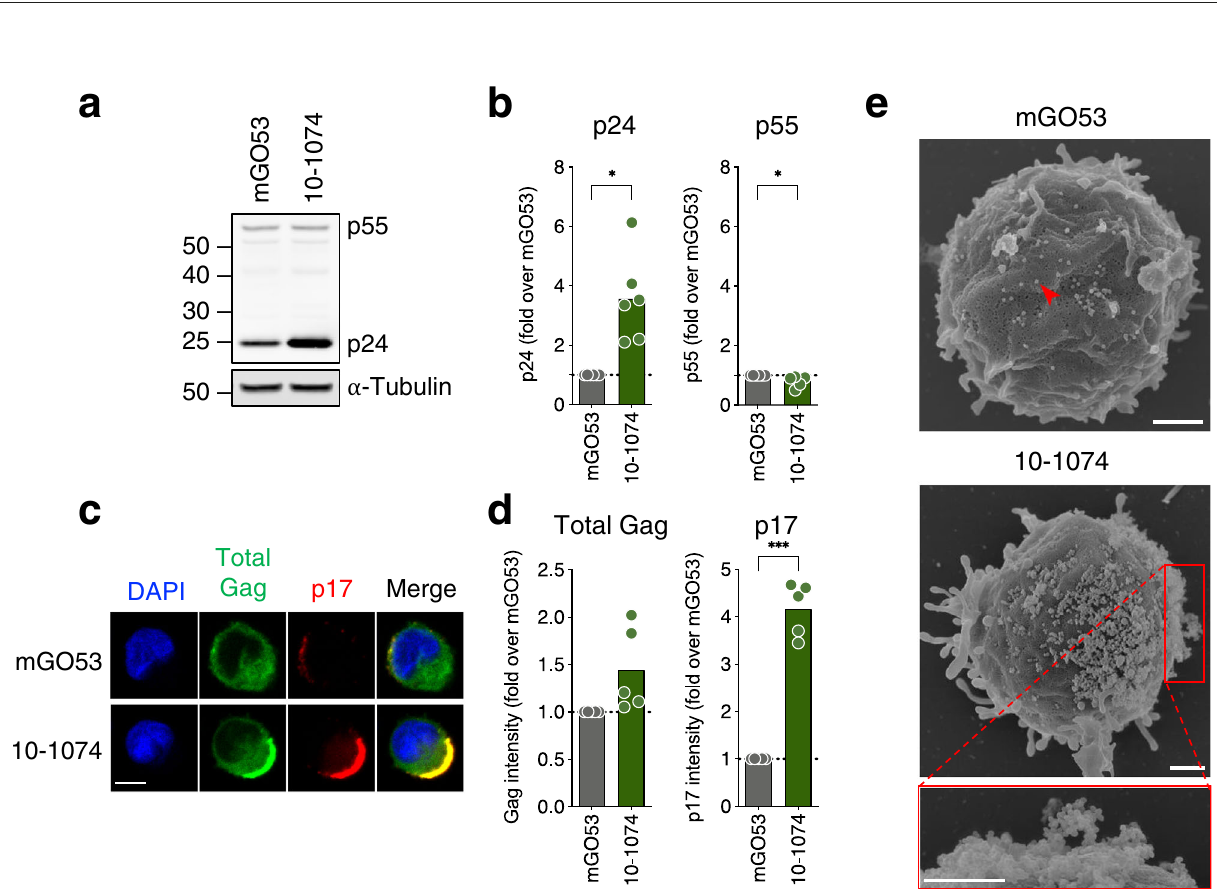
Fig. 2 bNAbs retain mature HIV-1 particles at the plasma membrane. a Western blot analysis of Gag in CD4 T cells infected with HIV-1 (CH058) for 48 h and then cultivated 24h with an isotype control (mGO53) or a bNAb (10 – 1074). α -Tubulin was used as a loading control. Molecular weights (kDa) are indicated on the left. One representative experiment (out of six) is shown. b Western blot analysis of p24 (left) and p55 (right) levels in HIV-1-infected (CH058) CD4 T cells cultivated for 24 h with an isotype control (mGO53) or a bNAb (10 – 1074). Results are normalized to α -Tubulin and to mGO53. Each dot represents a donor of CD4 T cells ( n = 6). * p = 0.0313 (two-tailed Wilcoxon test). Bars represent the mean. c Representative confocal microscopy images of infected CD4 T cells (CH058) cultivated for 24 h with an isotype control (mGO53) or with a bNAb (10 – 1074). Cells were stained for intracellular total Gag (green) and p17 (red). Nuclei were stained with DAPI (blue). Scale bar: 5 μ m. One representative experiment (out of fi ve) is shown. d Confocal microscopy analysis of total Gag and p17 intensity levels in infected (CH058) CD4 T cells cultivated for 24 h with an isotype control (mGO53) or with a bNAb (10 – 1074). Results are expressed as the fold-change in Gag staining intensity over mGO53. Each dot represents a donor of CD4 T cells ( n = 5). At least 50 cells were analyzed per donor. *** p = 0.0002 (two-tailed paired t-test). Bars represent the mean. e Representative scanning electron microscopy images of infected (CH058) CD4 T cells cultivated for 24 h with an isotype control (mGO53) or with a bNAb (10 – 1074). A red arrowhead points an HIV-1 viral particle as an example. Scale bar: 1 μ m. One representative experiment (out of two) is shown. Antibodies were tested at a concentration of 100 nM, corresponding to 15 μ g/mL. Source data are provided as a Source Data fi